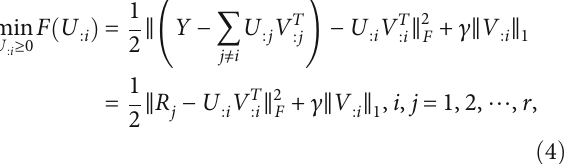
Algorithm 1: Pseudocode for